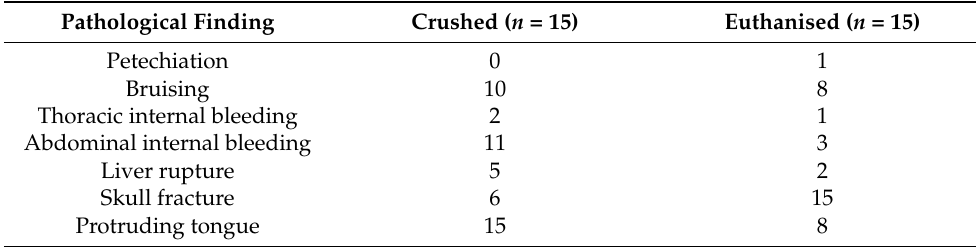
Table 3. Specific pathological findings associated with euthanasia and crushing. Pathological